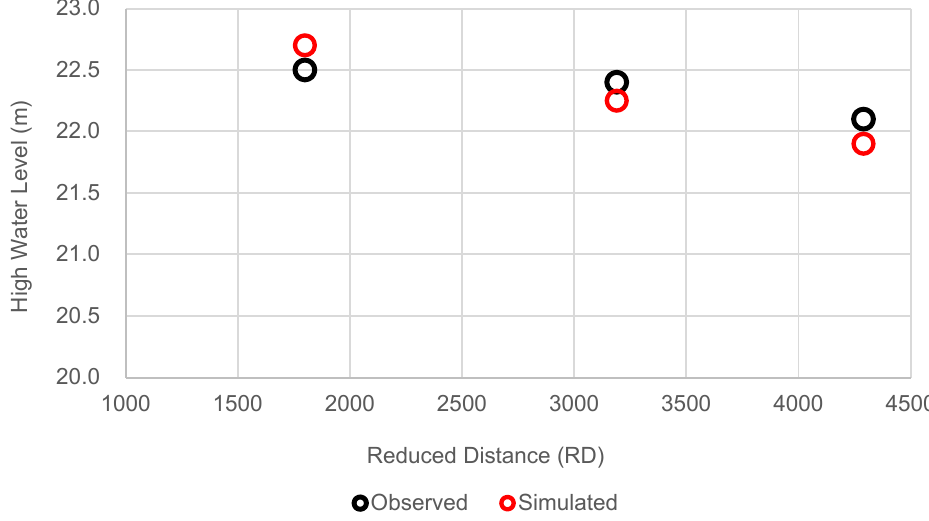
Figure 9. Validation of the hydraulic model by comparing the observed and simulated high water- marks of the 2010 flood downstream of the Kotri Barrage.